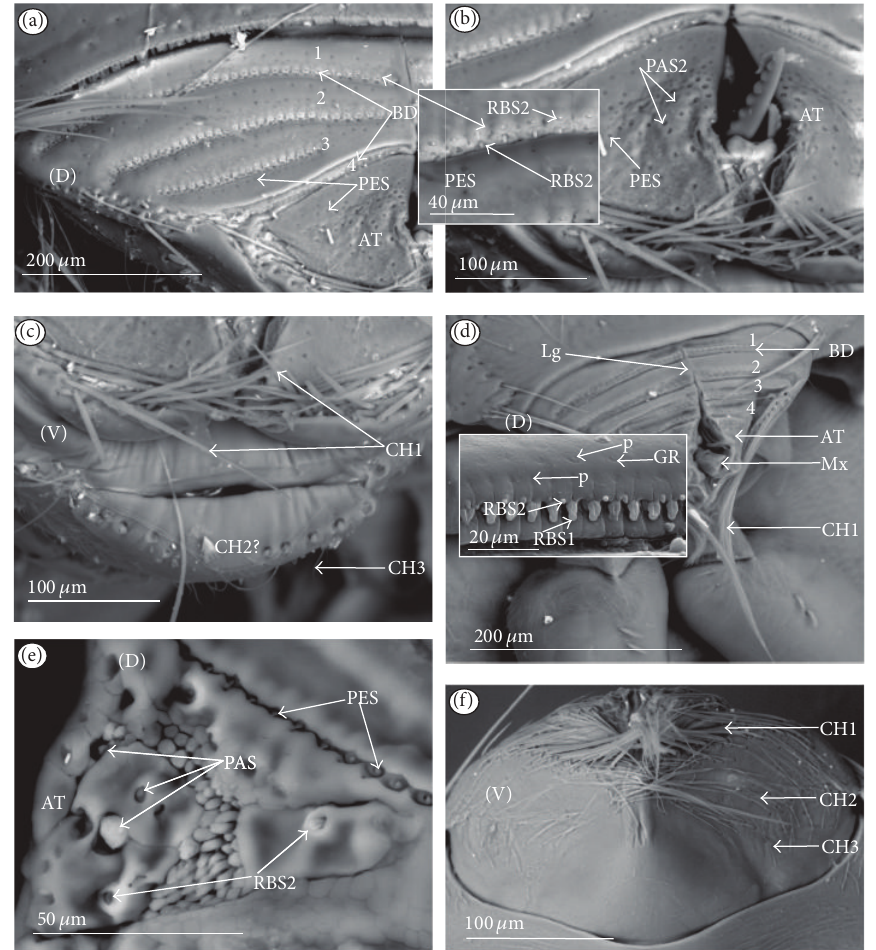
Figure 31: Types and sizes of the sensilla of the Diaprepocoridae and Micronectidae ((a)–(c) Diaprepocoris zealandiae , (d)–(f) Micronecta quadristrigata ). (a) BD (no. 1 − 2.5) are spread evenly on the dorsal surface. (b) AT in magnification; PES or PAS2 are numerous and unevenly cover the tip. (c) Several of the CH1 are arranged on the lateral edge of the membranous labial tip (AT); the CH1 are placed on the lateral edge of the labium; the CH2 and CH3 are placed below the apex, on the ventral side. (d) BD (no. 1–4) are spread evenly on the dorsal surface; the CH1 are placed on the lateral edge of the labium. (e) BD in magnification, PES, RBS2, and PAS on the apex (AT). (f) The CH1 are numerous and situated below the apex (ventral view), the CH2 are situated in a short row below the CH1, and the CH3 are not numerous and placed below the